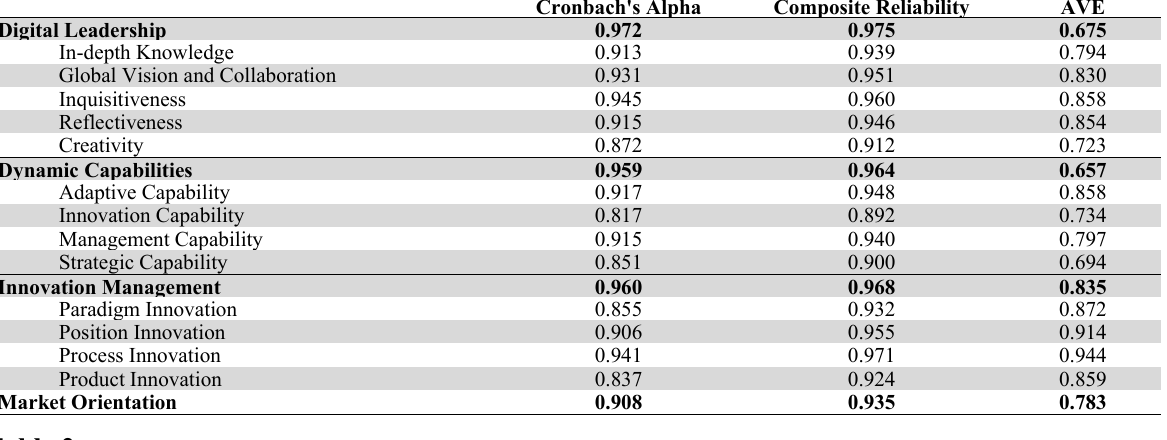
Construct Reliability Test